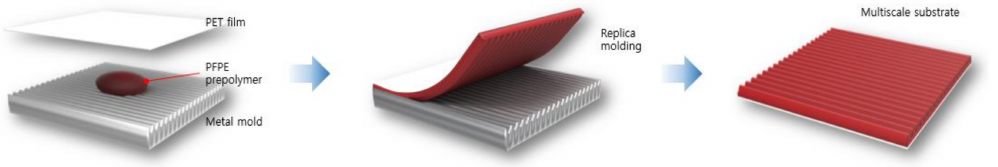
Figure 1. Fabrication scheme of perfluoropolyether (PFPE) replica replicated from the metal